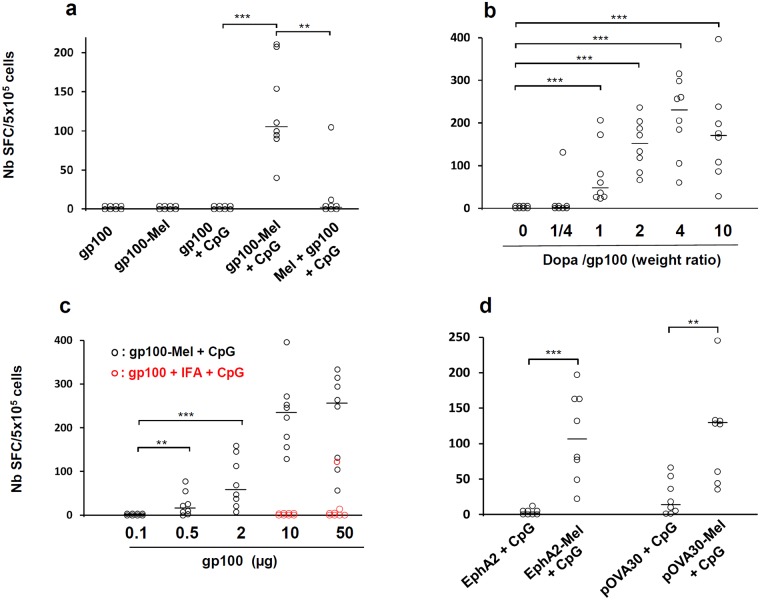
CTL response after subcutaneous immunizations in C57BL/6 mice.(a) Mice were immunized with gp100, gp100 + CpG, gp100-melanin (gp100-Mel), gp100-melanin + CpG (gp100-Mel + CpG), or previously synthesized melanin mixed with gp100 and CpG (Mel + gp100 + CpG). (b) Mice were immunized with gp100-melanin, synthesized with 10 μg gp100 and L-Dopa at various weight ratios. (c) Mice were immunized with gp100-melanin synthesized with various amounts of the gp100 epitope and L-Dopa at a weight ratio of 1:4 (gp100-Mel + CpG, black open circles). Some mice were immunized with 10 or 50 μg of gp100 in combination with incomplete Freund’s adjuvant and 50 μg of CpG (gp100 + IFA + CpG; red open circles). (d) Mice were immunized with EphA2 + CpG, EphA2-melanin + CpG [EphA2-Mel + CpG], pOVA30 + CpG, or pOVA30-melanin + CpG [pOVA30-Mel + CpG]. In a), b) and d), mice were immunized on days 0 and 7 and sacrificed on day 14. In c), mice were immunized on day 0 and sacrificed on day 8. Each point represents an individual mouse (n = 8 mice/group with pooled data from 2 different experiments of 4 mice each). SFC: spot-forming cells; Bars = median. ** p < 0.01; ***p<0.001 (Mann–Whitney test).